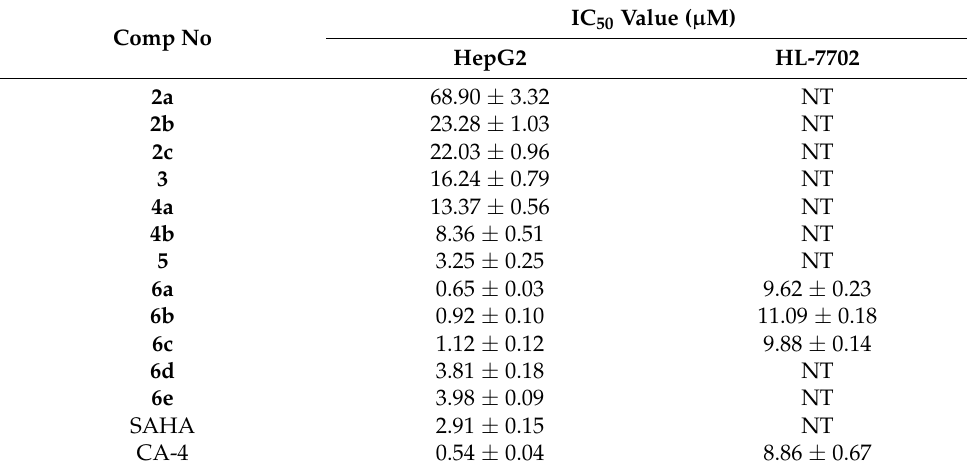
Table 1. Cytotoxic screening of the tested amides 2a-6e. Values are the mean of three independent replicates ± SE.